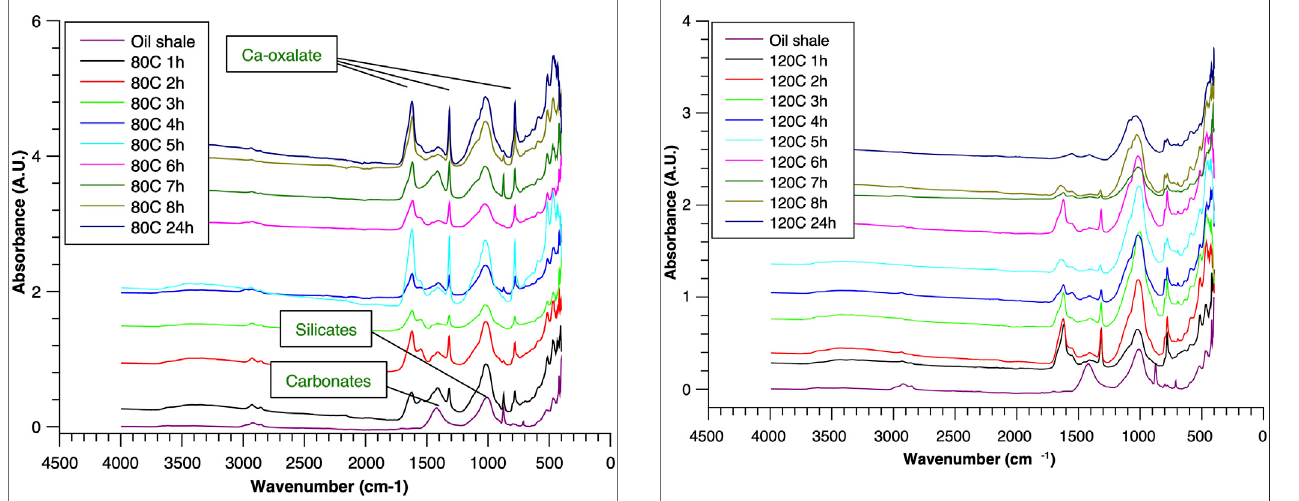
FIGURE 5 | ATR – FTIR of oil shale and reaction residues at 120 °